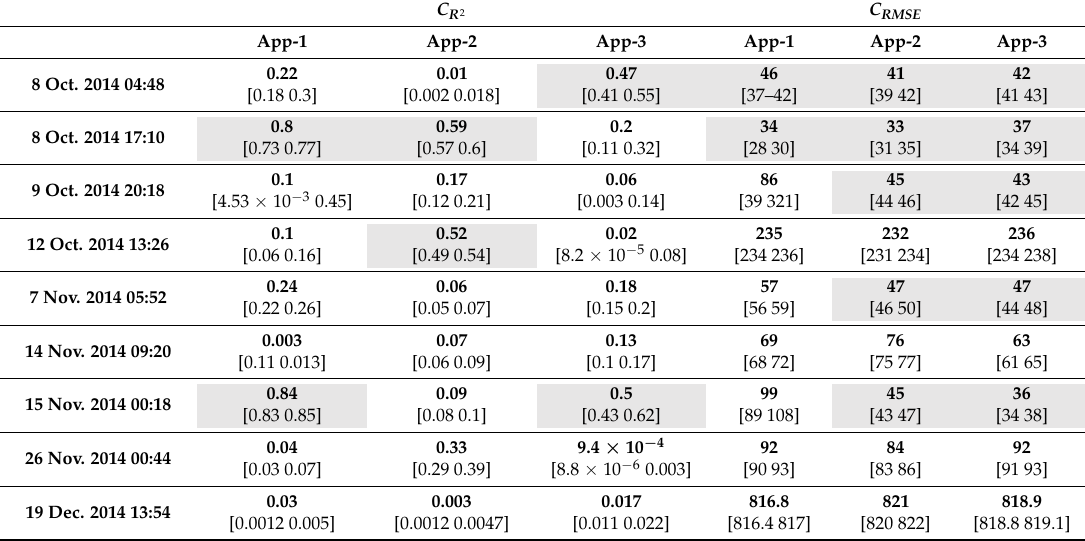
Table 4. Mean [Min Max] Determination and RMSE coefficients calculated between the observed and simulated TSS concentrations for three modeling approaches for each of the nine events. The grey cells represent the simulations for which the C R 2 is higher than 0.5. C R 2 C RMSE App-1 App-2